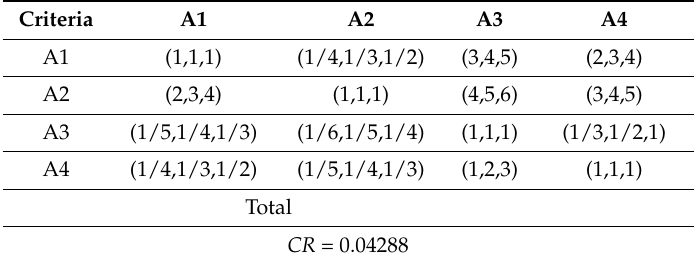
Table 6. Comparison matrix for A.